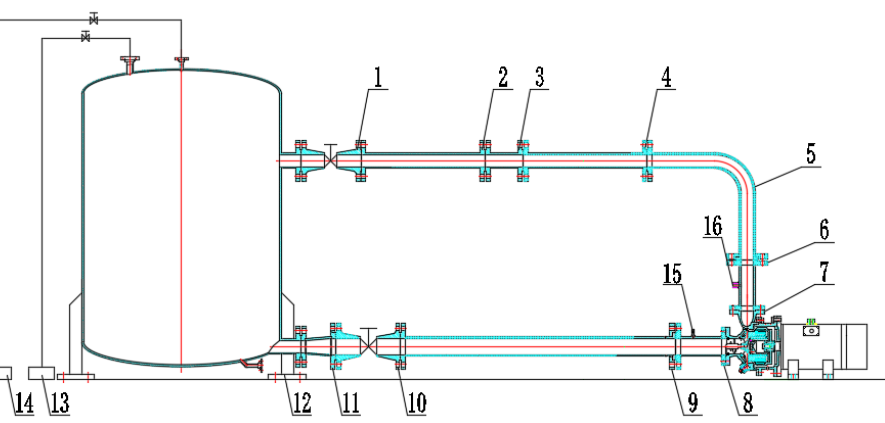
Figure 7. Schematic diagram of the test platform. 1—Outlet valve; 2, 4, 5, 6—Outlet pipe; 3—Flowmeter; 7—Test pump; 8, 9, 10—Inlet pipe; 11—Inlet valve; 12—Water tank; 13—Vacuum pump; 14—Air compressor; 15—Inlet pressure sensor; 16—Outlet pressure sensor.